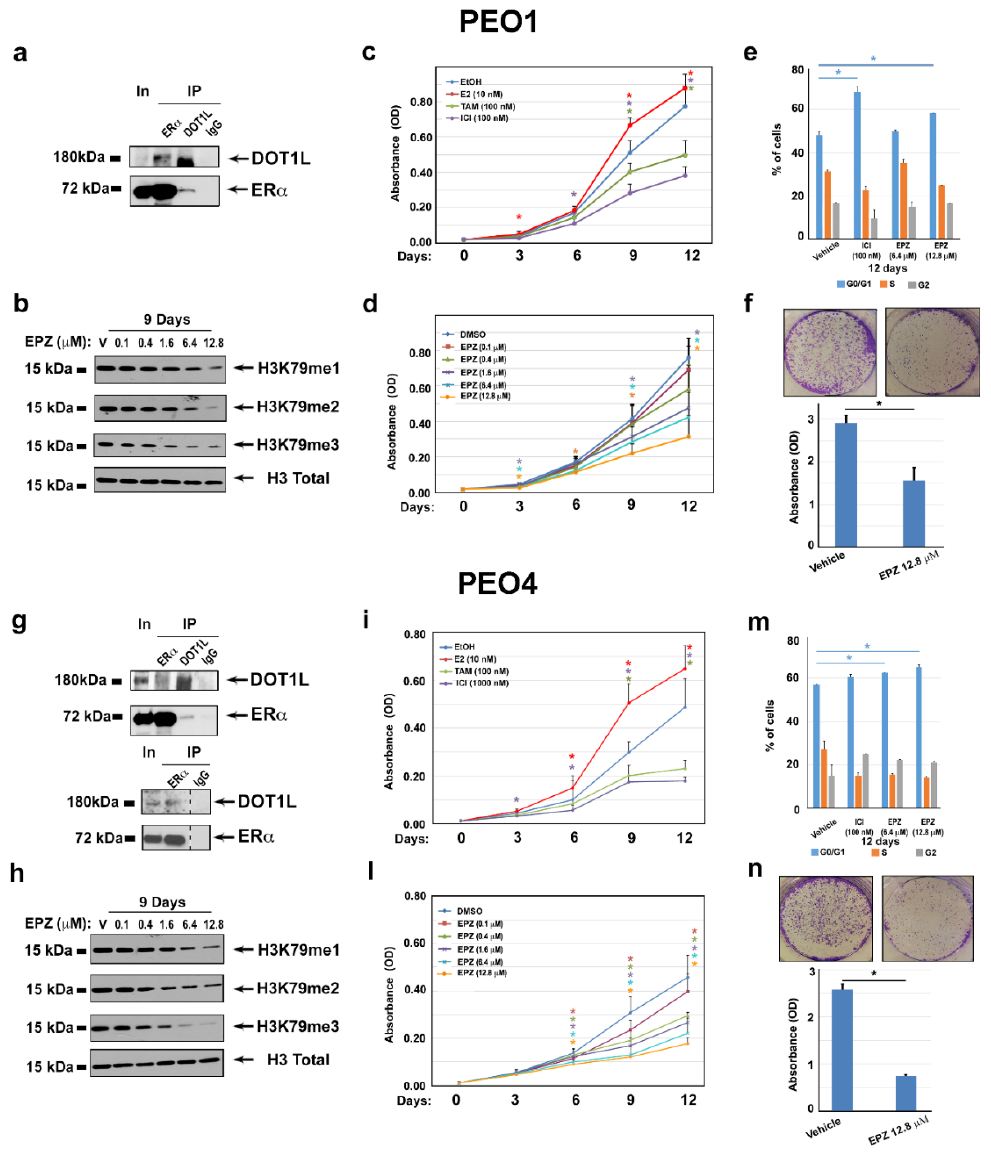
Figure 3. Functional e ff ects of ER α / DOT1L complex disruption by pharmacological inhibition. ER α and DOT1L co-immunoprecipitation in PEO1 ( a ) and PEO4 ( g ) nuclear extracts (the lower panel in g shows the results of an independent ER α IP test). WB analysis performed in PEO1 ( b ) and PEO4 ( h ) cells showing the e ff ect on H3K79me1, me2, and me3 compared to total H3 after nine days of treatment with vehicle (V, DMSO) or increasing concentrations of EPZ004777 (EPZ). The MTT assay performed in the presence of estrogen (17 β -estradiol, E2) (10 nM), antiestrogens Tamoxifen (TAM) (100 nM), and ICI 182 780 (ICI) (100 nM) ( c and i ), or increasing concentrations of EPZ ( d and l ). Vehicles (EtOH or DMSO) were used as negative controls. Bar plots of PI-stained PEO1 ( e ) and PEO4 ( m ) cells showing percentages of G1, S, and G2 / M cells after 12 days of treatment with ICI, EPZ, or the control vehicle, as indicated. A colony formation assay performed in triplicate on PEO1 ( f ) and PEO4 ( n ) cell lines treated with vehicle (V, DMSO) or 12.8 µ M of EPZ for 12 days. Colonies were visualized by crystal violet staining. Error bars represent the mean of replicate values ± SD (* p ≤ 0.05).